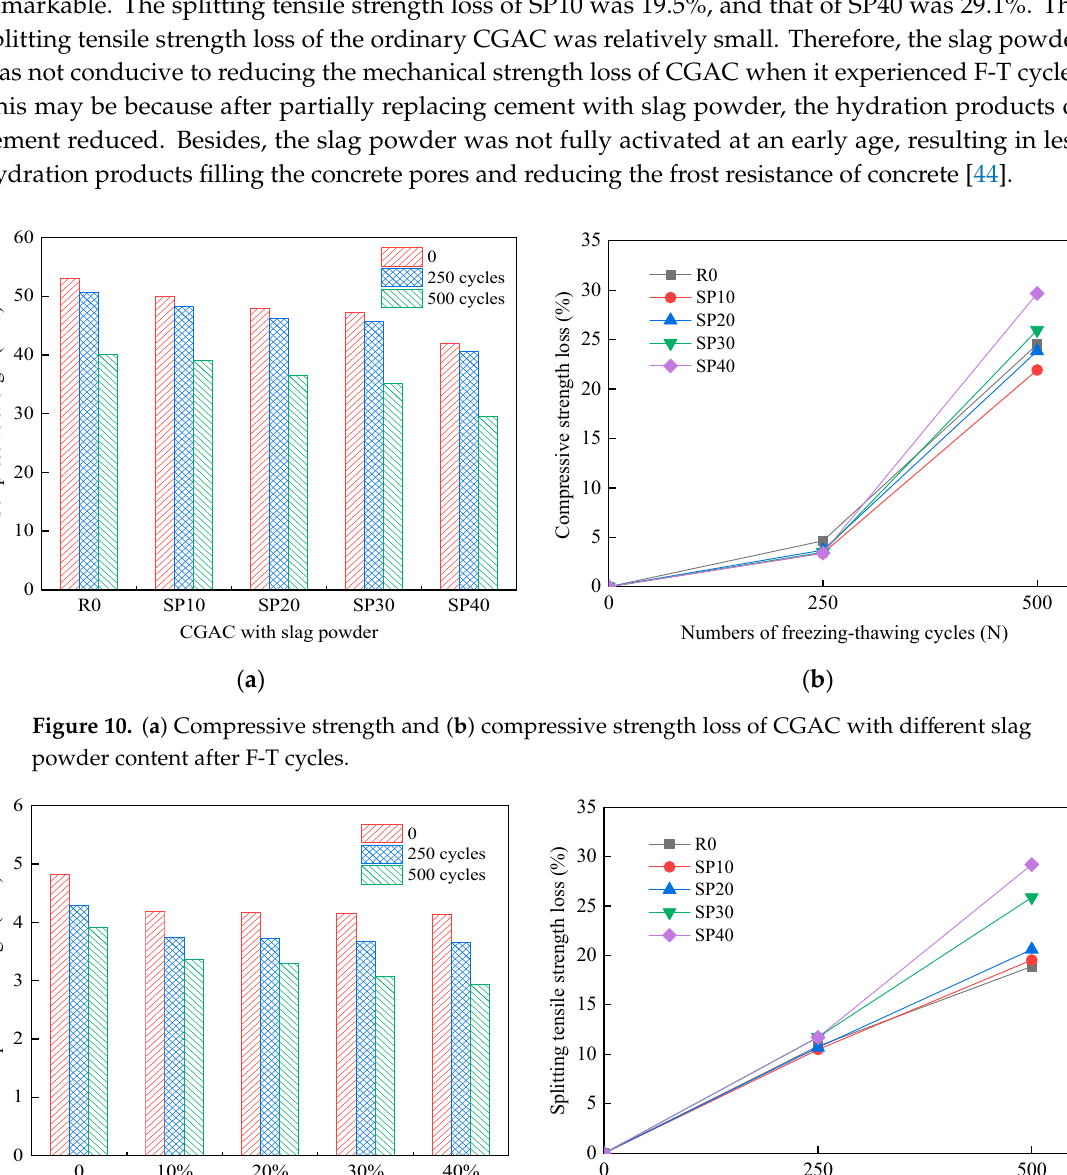
Figure 11. ( a ) Splitting tensile strength and ( b ) splitting tensile strength loss of CGAC with di ff erent slag powder content after F-T Figure 11. (a) Splitting tensile strength and (b) splitting tensile strength loss of CGAC with different slag powder content after F-T cycles.